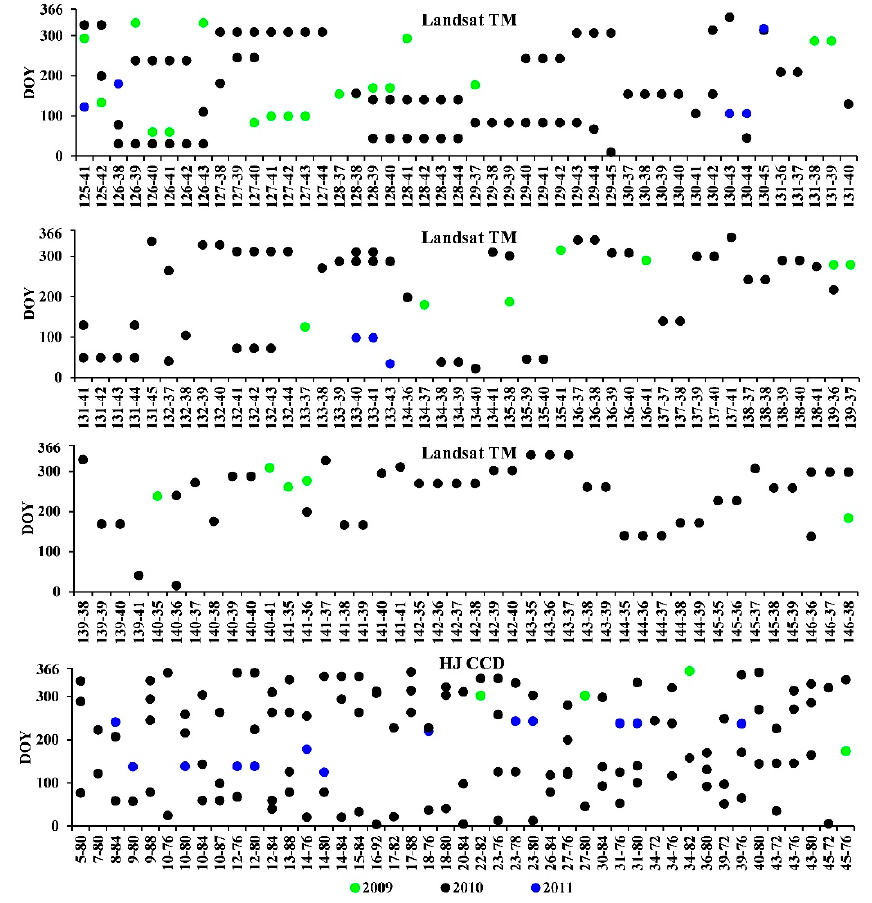
Figure 3. The temporal distribution (DOY, day of year) of Landsat TM images and HJ-CCD images for each tile in Southwestern China. The X-axis was the scenes (path-row) of the Landsat TM images and the HJ-CCD images.